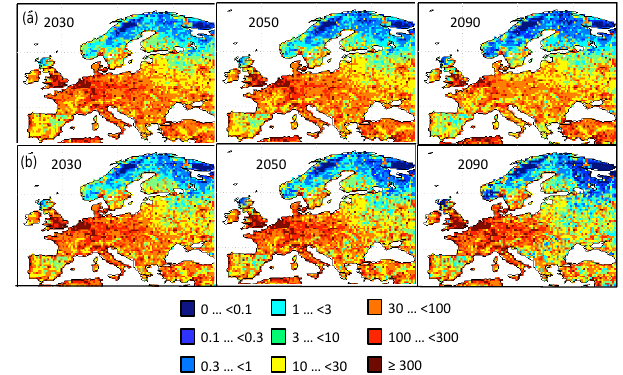
Figure A2. Projected population density (inhabitantskm − 2 ) in Eu- rope: (a) SSP3 and (b) SSP5.